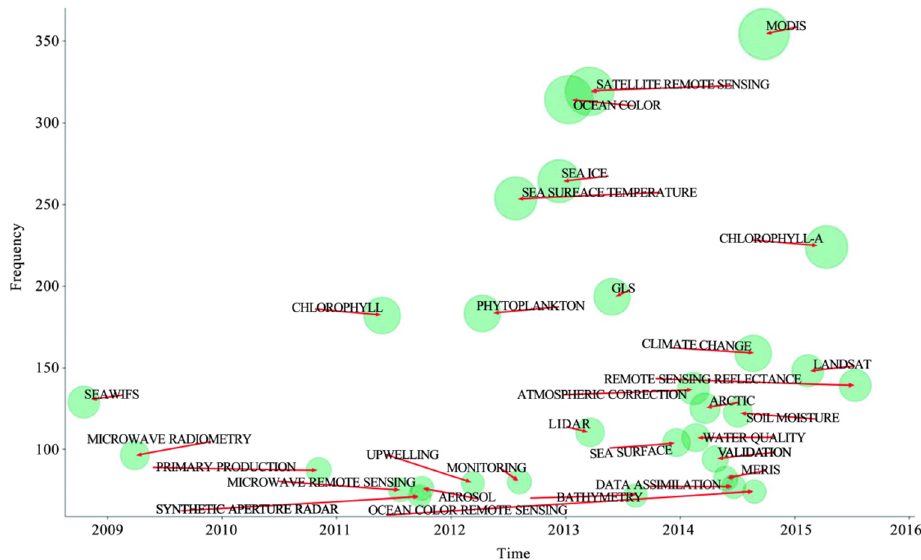
Figure 6. The evolution of hot words. Each circle represents a hot word, and its size indicates the frequency of the word.